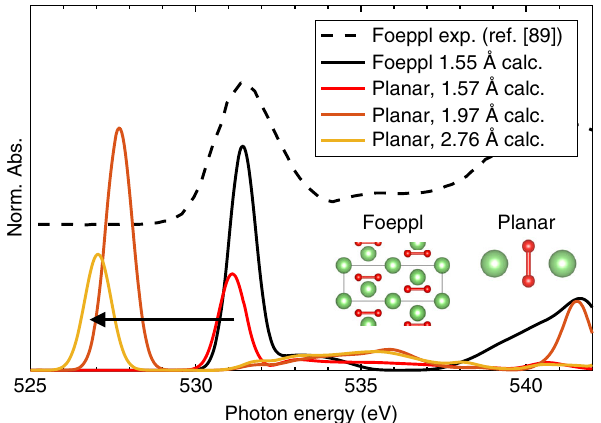
Fig. 7 Ab initio XAS of Li 2 O 2 as a function of O – O separation. Experimental and calculated XAS of a relaxed Li 2 O 2 crystal in the Foeppl structure 89 (middle) with an O – O bond length of 1.55 Å, and calculated spectra of an arti fi cial planar Li 2 O 2 molecule (right) with various bond lengths. The molecule was fi rst allowed to relax, yielding the 1.57 Å O – O bond length, which was then stretched arti fi cially to create the subsequent molecular structures. Ab initio XAS was performed in the spin polarized DFT-XCH framework, as described previously